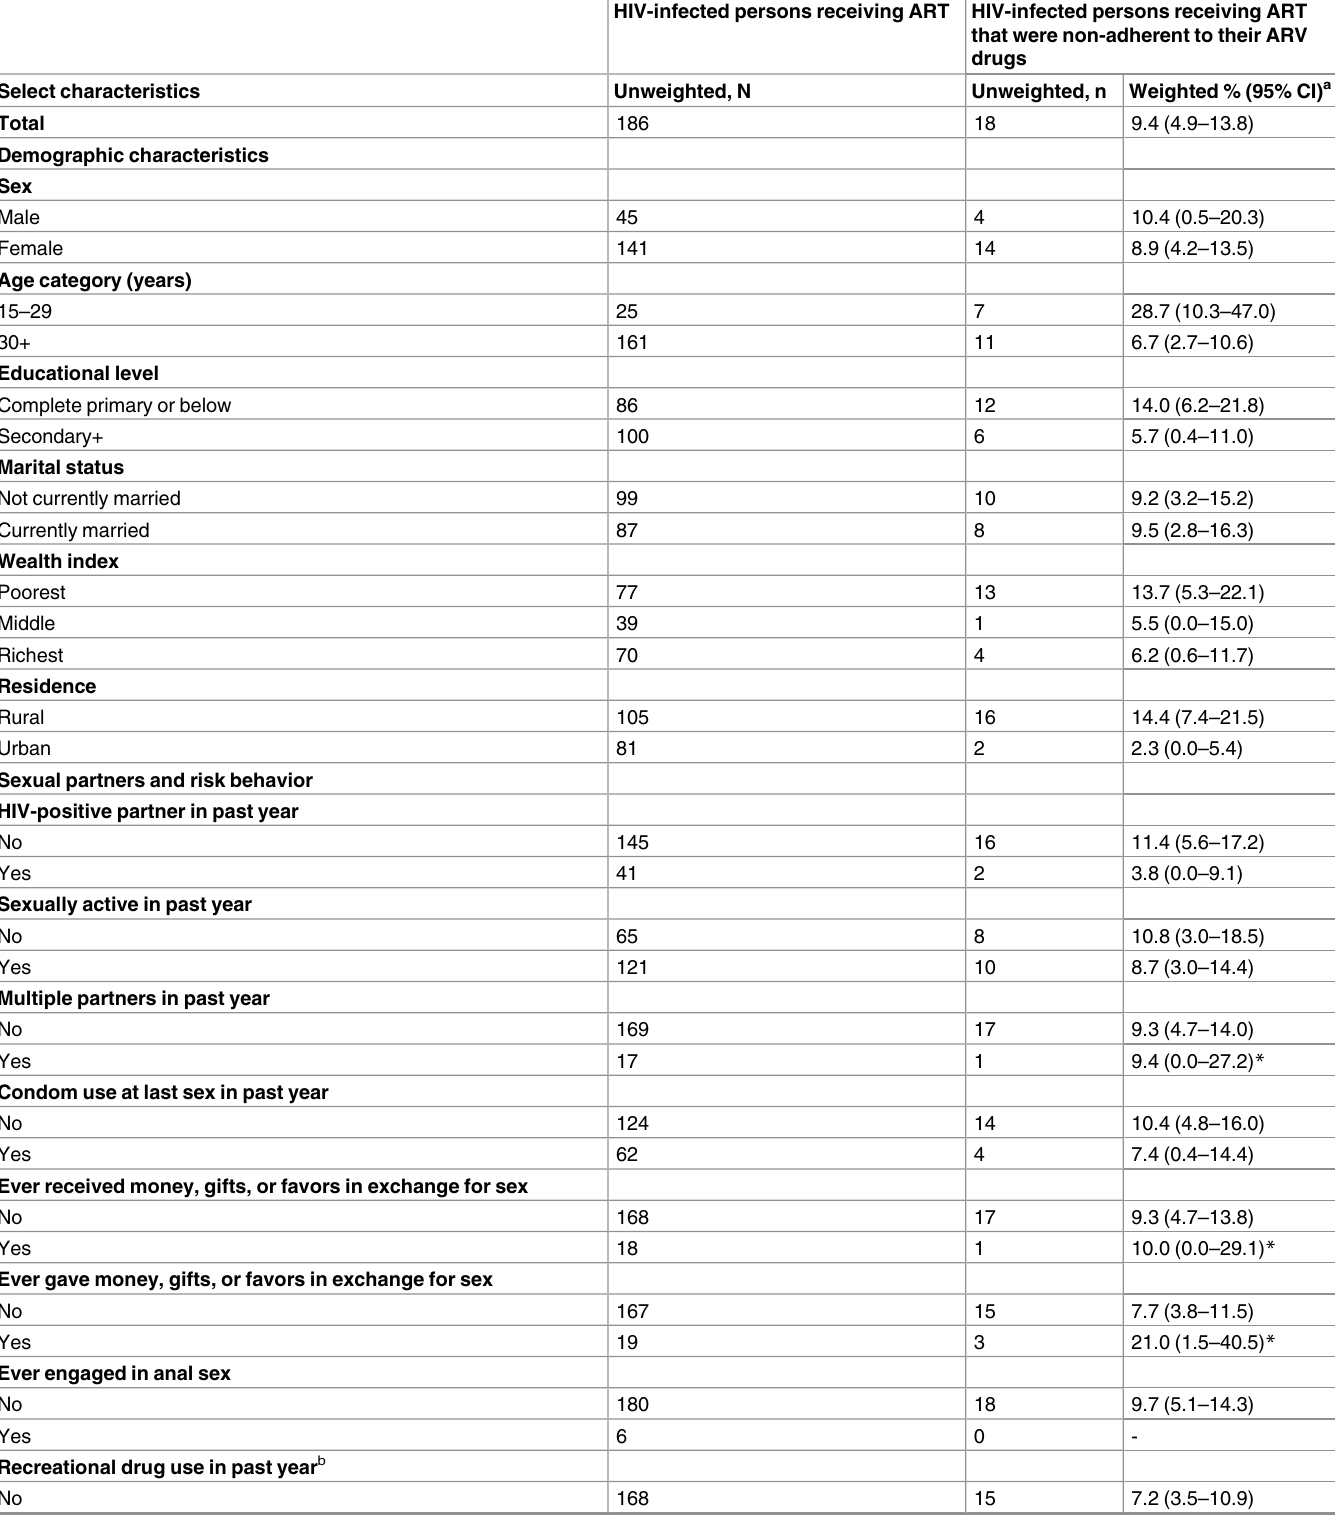
Table 1. Non-adherence to ARV drugs among HIV-infected persons receiving ART by select characteristics, Kenya,